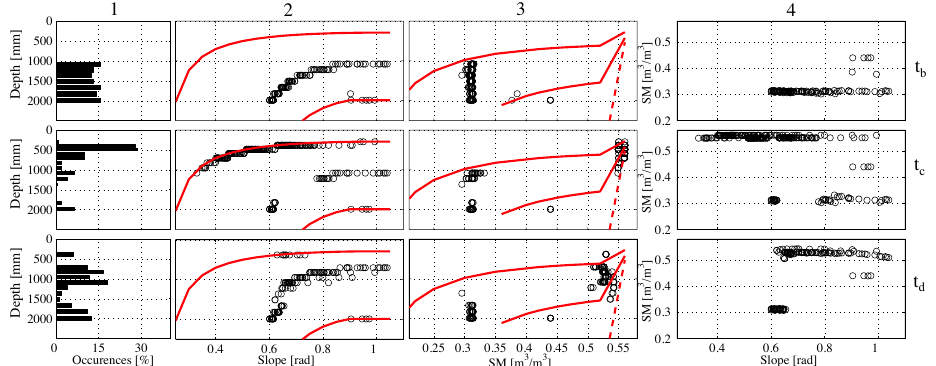
Fig. 9. Frequency distribution of failure depths (column 1), scatterplots of slope vs. depth (column 2) and SM vs. depth (column 3) for all failing elements at time steps increasing with rows ( t b ,t c ,t d ) with anisotropy equal to 1. The red lines designate the limits of the region of all possible instability cases. For column 2, the upper red line describes the worst conditions obtained from Eq. (3) at a fully saturated state of the most permeable soil (sandy loam), and the lower line is obtained from Eq. (3) at unsaturated conditions for the minimum value of soil moisture at which a failure occurs (0.29m 3 m − 3 ) ; for column 3, the red lines are obtained from Eq. (3) at fixed slope values by considering the steepest slope (63 ◦ , ∼ 1.1rad, upper red line) and two gentler slopes (35 ◦ , ∼ 0.6 rad, lower solid line; 23 ◦ , ∼ 0.4rad, dashed line).